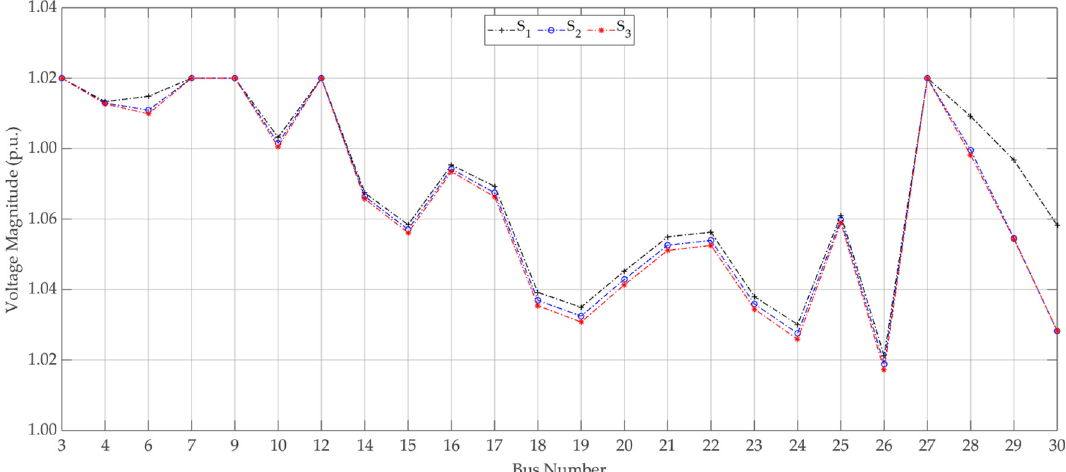
Figure 2. Voltage profile of the load buses for probabilistic multi-objective RPP considering the load demand uncertainty.